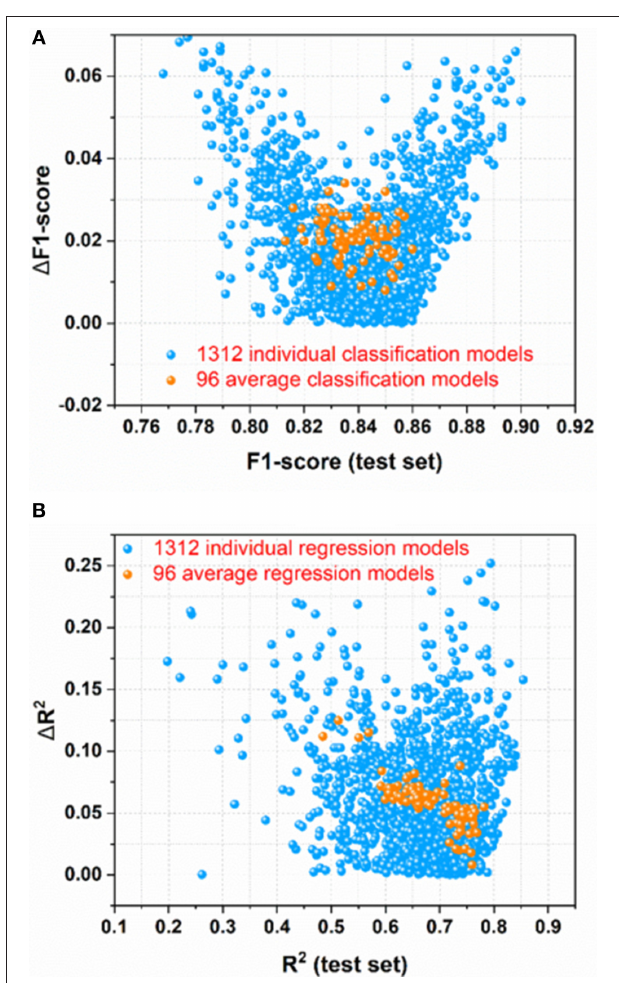
FIGURE 3 | (A) the scatter-plot of 1 F1-score vs. F1-score for all the classification models; (B) The scatter plot of 1 R 2 vs. R 2 (test set) for all the regression models. 1 F1-score [referring to |F1-score (test set)–F1-score(cross-validation)|] and 1 R 2 [referring to |R 2 (test set)–R 2 (cross-validation)|] are used to monitor the potential overfitting or underfitting.